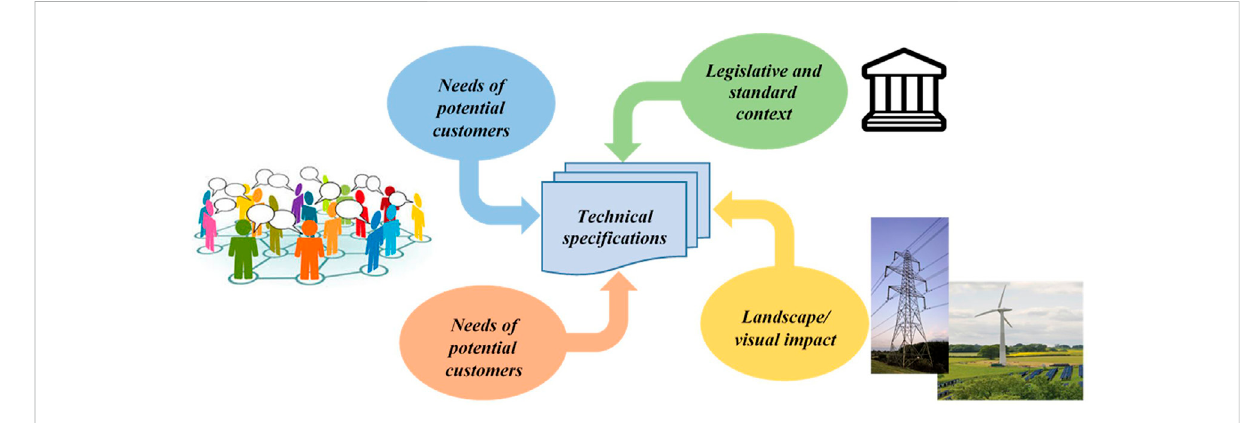
FIGURE 3 De fi nition of technical speci fi cations.